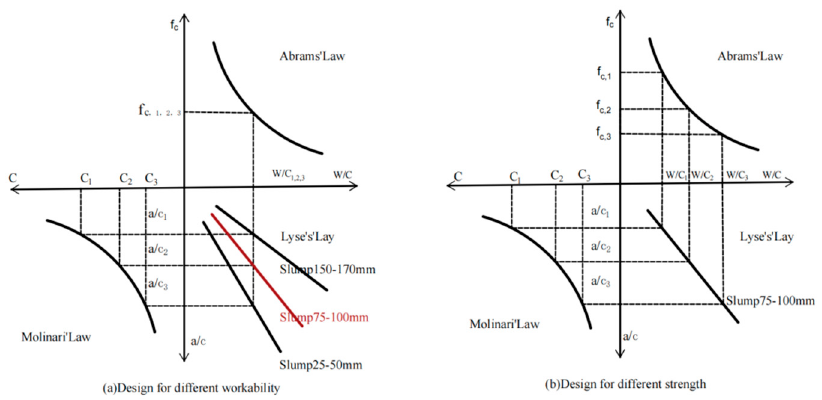
Figure 7. Design for different workability values and design for different strength values [65].